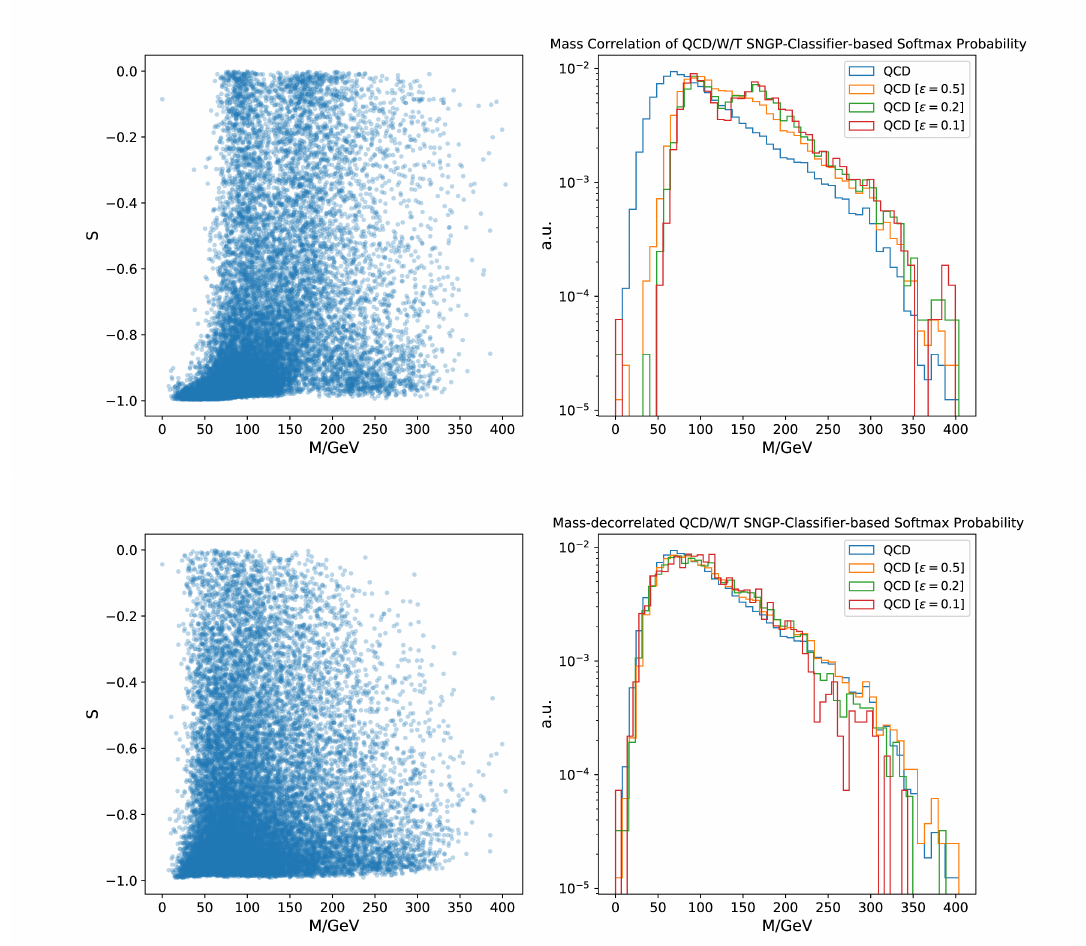
Figure 13 . SNGP Model. Top : The un-decorrelated model with p QCD as the anomaly score. Bottom : The mass-decorrelated model with p QCD as the anomaly score. Left : The correlation between jet mass M and the anomaly score. Right : Mass distributions for different background acceptance rates ( (cid:15)